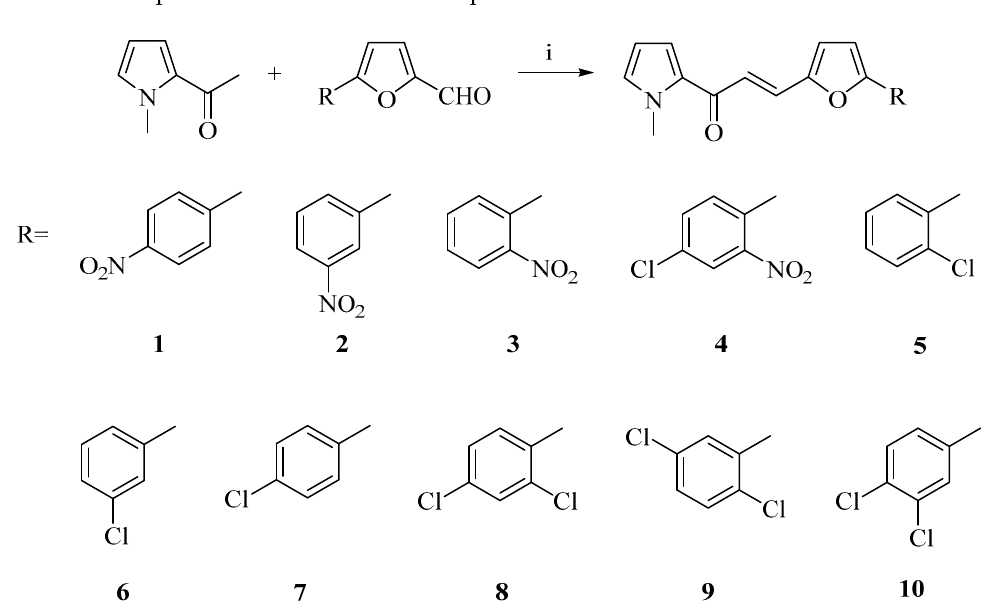
Figure 2. The synthetic route for the preparation of the chalcone derivatives ( 1 – 10 ). Reagents and conditions: (i) NaOH, methanol, r.t., 48 h.